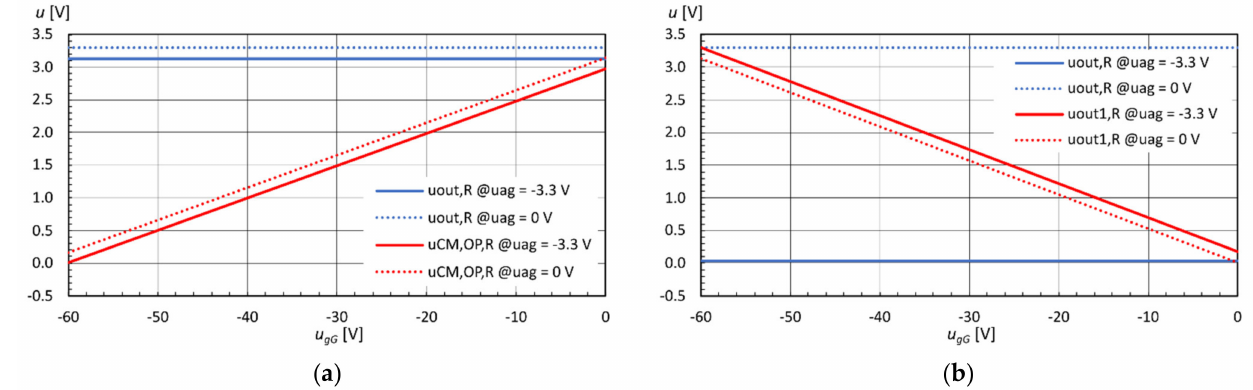
Figure 13. Characteristic voltages vs. u gG for the reversed u ag connection: ( a ) single-stage circuit; ( b ) two-stage circuit.